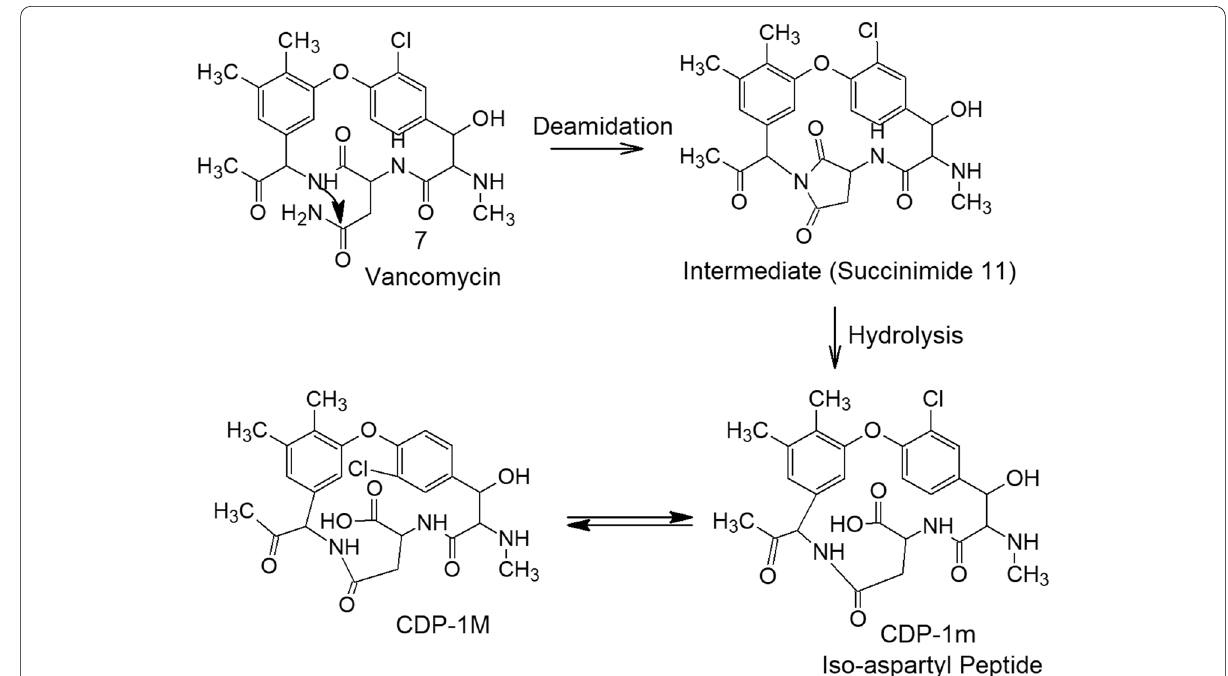
Fig. 5 Deamidation, hydrolysis, and rearrangement of vancomycin to form degradation products